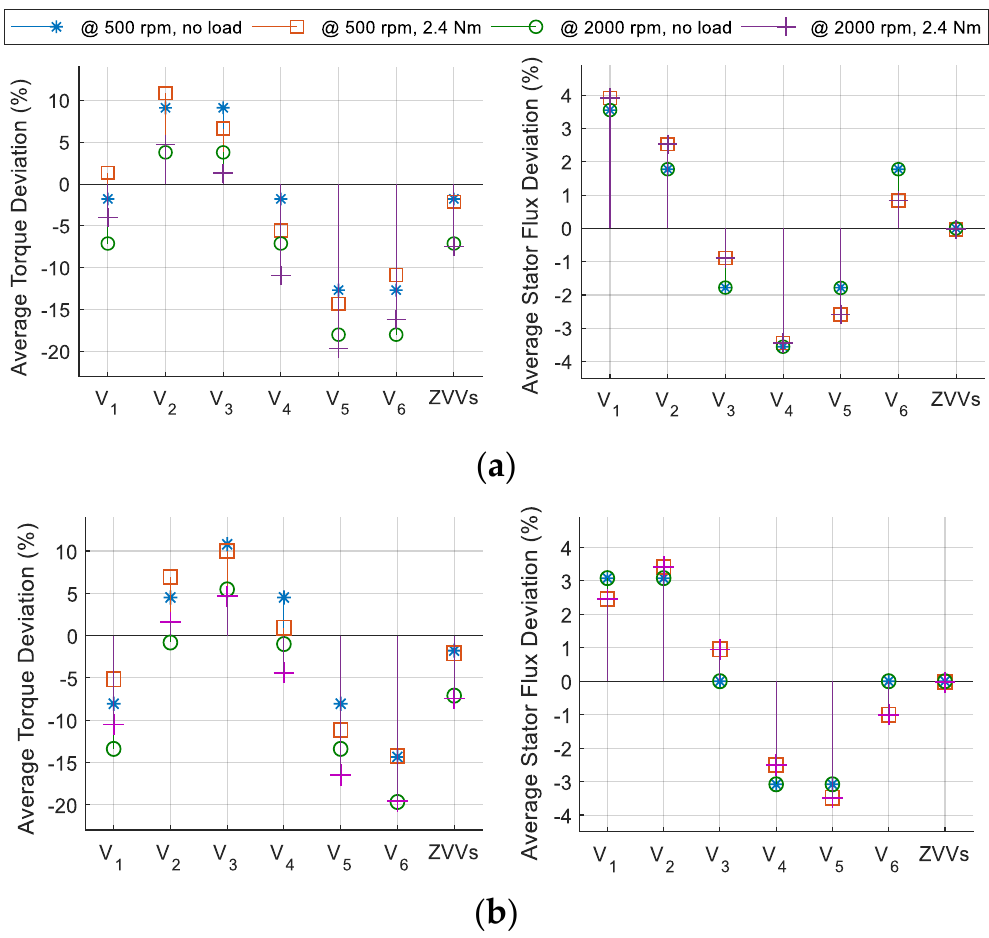
Figure 3. Average torque and stator flux deviations in percentage of their rated values, produced by each voltage vector at different operating conditions, sampling period of 25 μs, and x = 1 with ( a ) the traditional sector boundaries ( θ s ∈ [ − 30 ◦ , 30 ◦ ]) and ( b ) the modified boundaries ( θ s ∈ [0 ◦ , 60 ◦ ]).